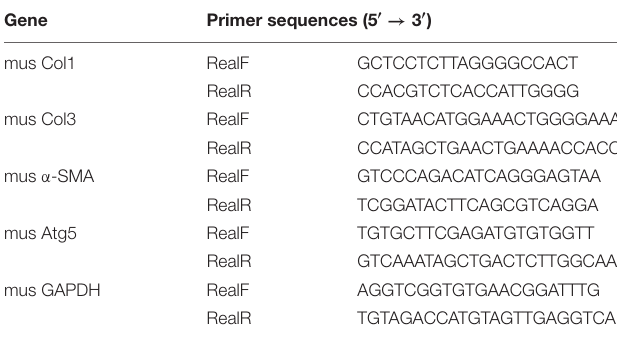
TABLE 2 | The RT-PCR primer sequences for